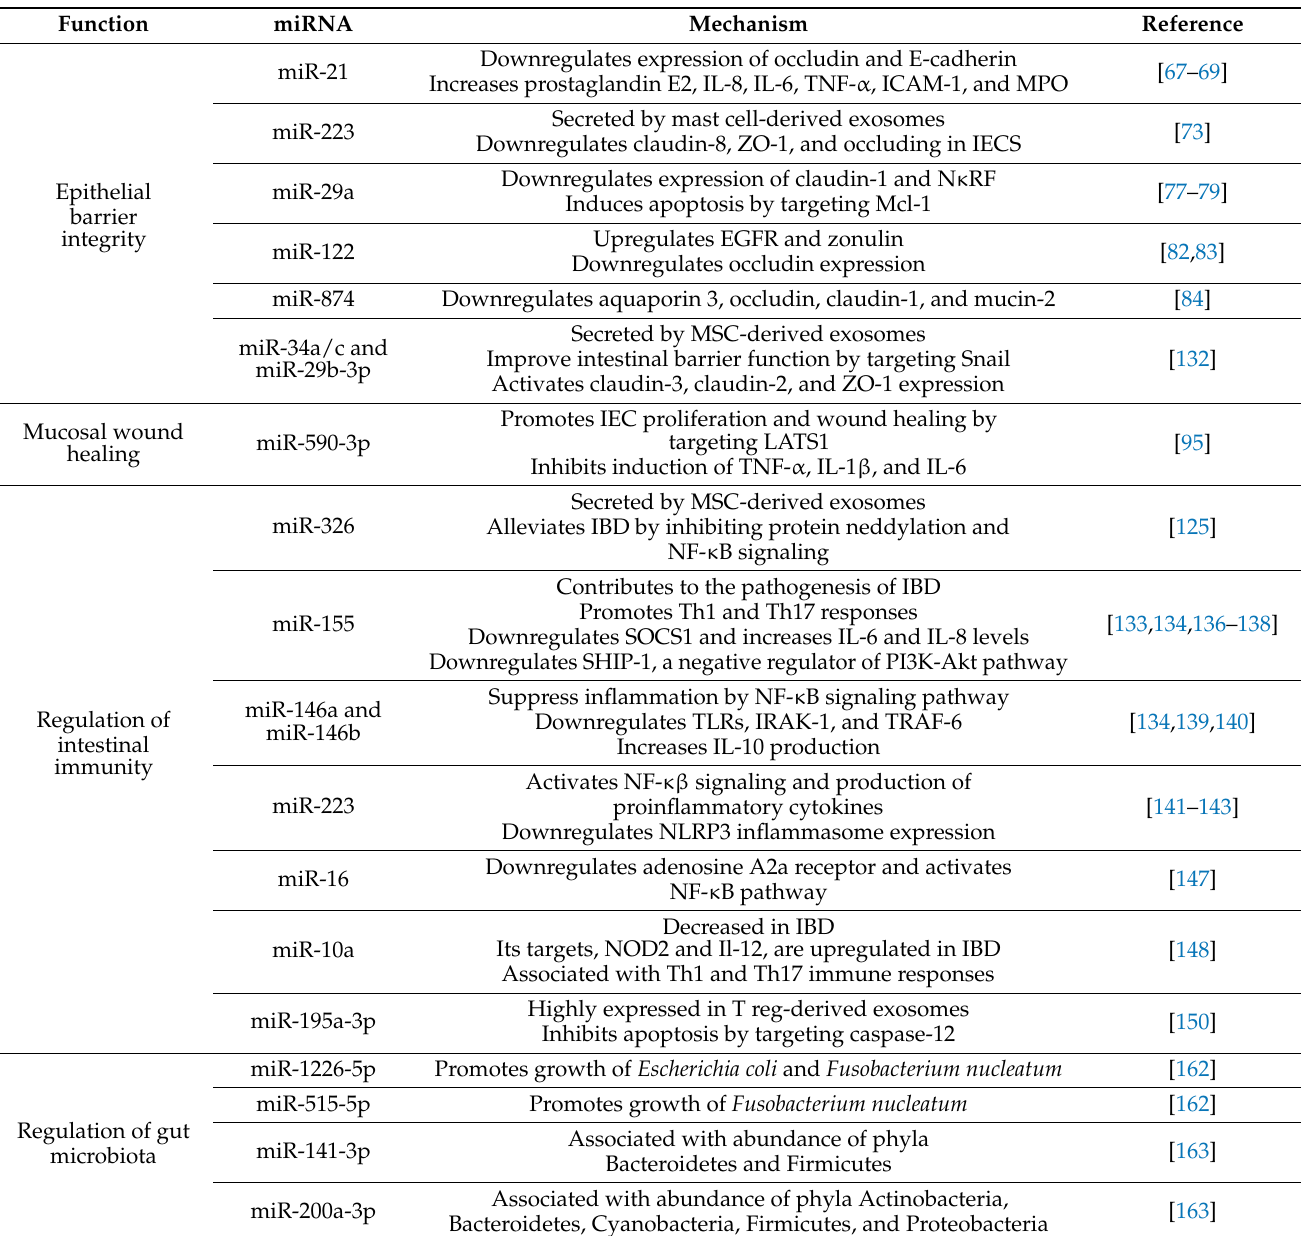
Table 1. Micro-RNAs transported through EV important in the gut